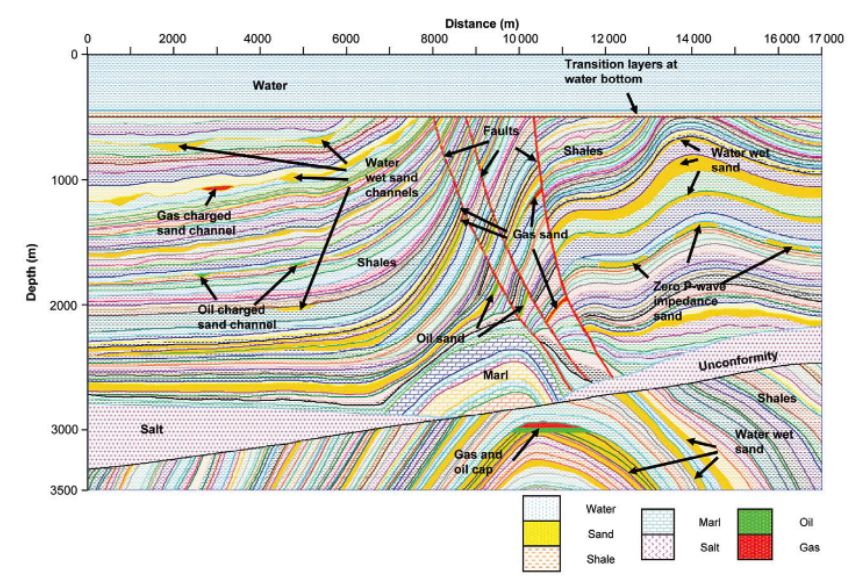
Figure 7. Detail of structures from Marmousi2 dataset. Source: extracted from